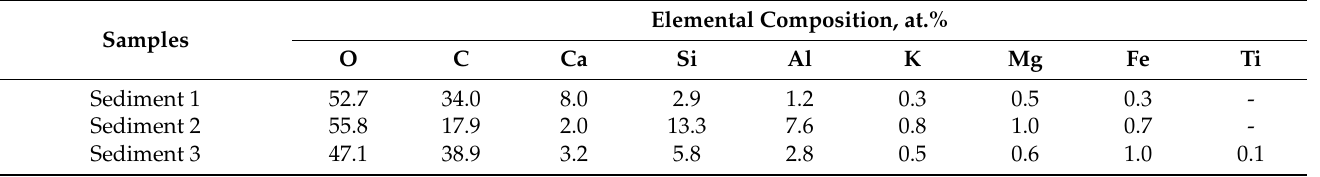
Table 2. Elemental compositions of the mineral fractions within amphora sediments.